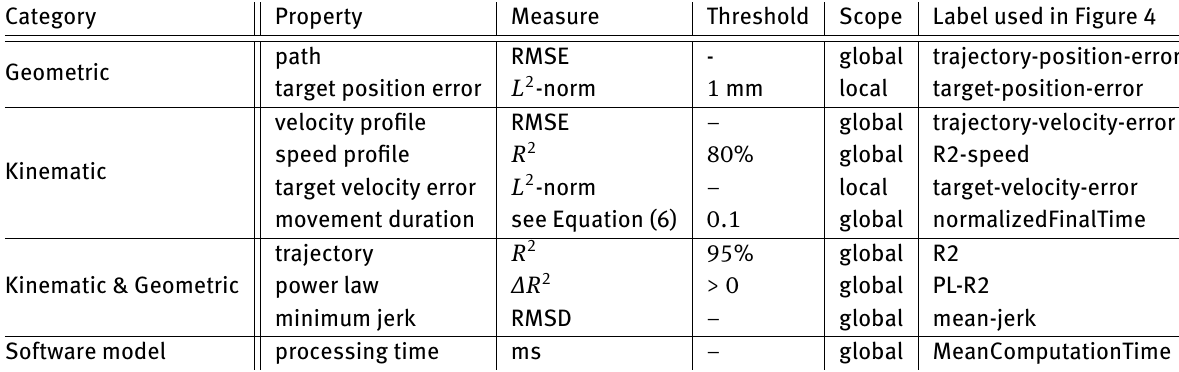
Table 1: Overview of different categories of measures used in the benchmark for performance evaluation of each participant. The optimality threshold is given for each measure in the context of the described data set (see Section